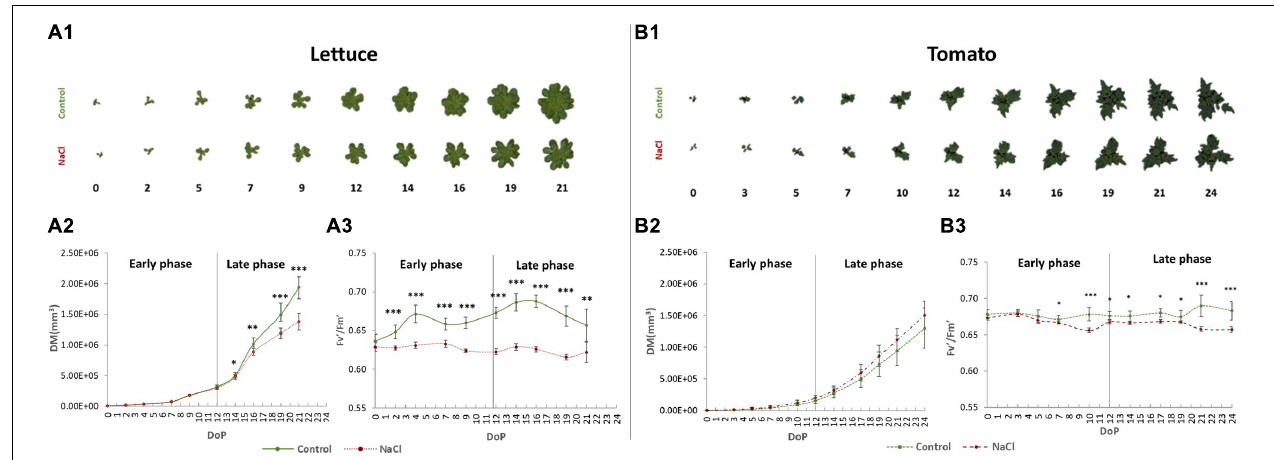
FIGURE 2 | Salinity response in tomato and lettuce plants. The RGB top view colour-segmented images of lettuce (A1) and tomato (B1) control and salinity-stressed plants over the time-course of the experiment. Digital biomass (DB) of the lettuce (A2) and tomato (B2) plants. The maximum quantum efficiency of photosystem II in the light-adapted state (Fl (cid:48) /Fm (cid:48) ) for lettuce [full line, (A3) ] and tomato [dashed line, (B3) ] plants. Values represent the average of 8 (lettuce) and 6 (tomato) biological replicates per treatment, error bars represent standard deviation. The significant differences between control and salt treatment are indicated with ∗ , ∗∗ , and ∗∗∗ for p -values below 0.05, 0.01, and 0.001, respectively. Data and images shown are from the 1st round of the lettuce experiment.